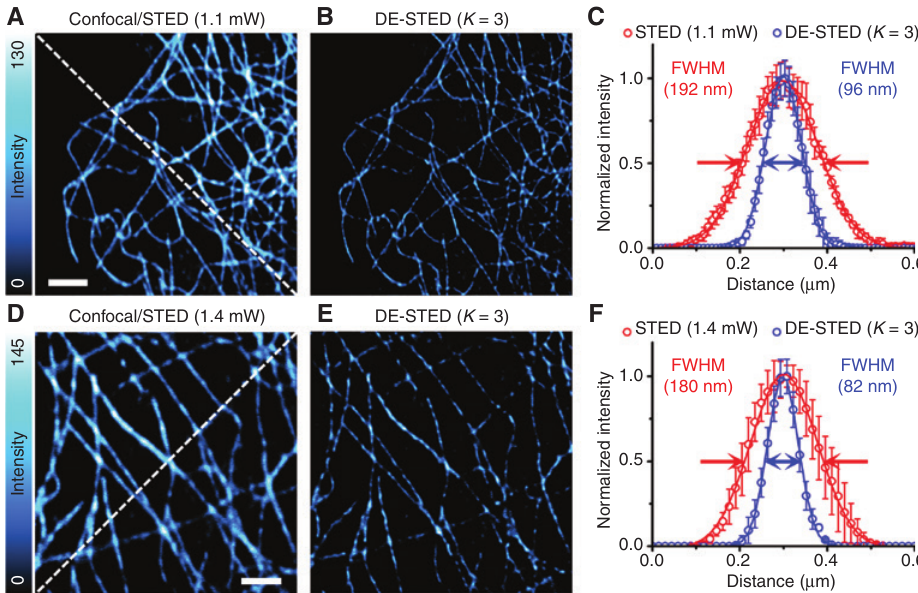
Figure 5: Digitally enhanced STED imaging of fixed BSC-1 cells. The comparison of confocal and STED images at a depletion power of 1.1 mW. Pixel size: 10 nm; FOV: 20 × 20 μ m 2 . Scale bar, 3 μ m. (B) A DE-STED image of the same area in (A) with a K value of 3. (C) The mean cross-section of the microtubules in the STED and DE-STED images in (A) and (B). (D) The comparison of confocal and STED images at a depletion power of 1.4 mW. Pixel size: 15 nm; FOV: 13 × 13 μ m 2 . Scale bar, 2 μ m. (E) A DE-STED image of the same area in (D) with a K value of 3. (F) The mean cross-section of microtubules in the STED and DE-STED images in (D) and